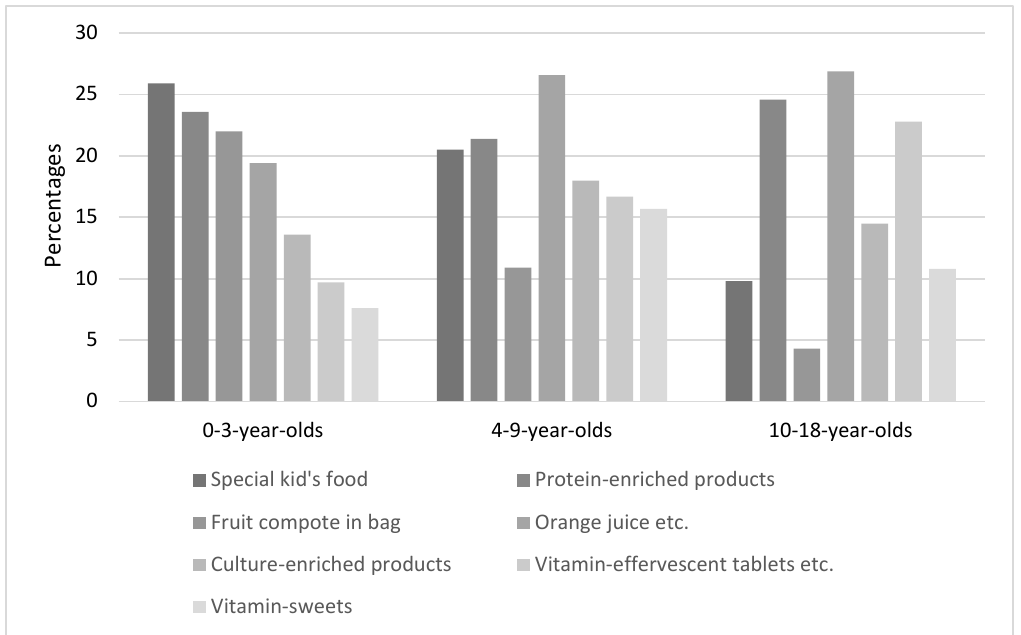
Figure 1. Percentages of supplements/food bought to promote health per age group.